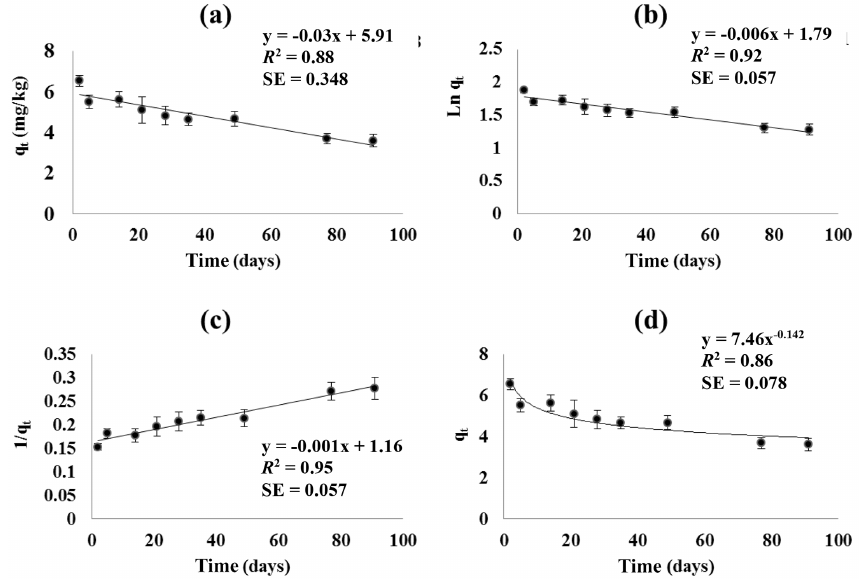
Figure 2. Amount of diethylene triamine pentaacetic acid (DTPA)-extractable copper over the long term (90 days) in the chelated system fitted to (a) zero-order, (b) first-order, (c) second-order, and (d) power function models ( q t denotes the amount remaining at time t (mgkg − 1 ); error bars are for standard errors computed from six data points). Table 7. Experimental data from copper kinetic studies fitted to zero-, first-, and second-order models, and power function models. Copper Depth Zero First Second Power system (cm) R 2 SE R 2 SE R 2 SE R 2 SE Non-chelated 0–15 ( n = 3) 0.64 0.705 0.71 0.148 0.75 0.035 15–30 ( n = 3) 0.56 0.828 0.68 0.155 0.77 y s All ( n = 6) 0.61 0.751 0.71 0.145 0.79 0.030 0.91 0.081 90d a Chelated 0–15 ( n = 3) 0.79 0.477 0.83 0.09 15–30 ( n = 3) 0.88 0.337 All ( n = 6) 0.88 0.348 0.92 0.71 Chelated All ( n = 6) 0.82 0.327 0.85 0.054 0.87 0.009 0.87 0.049